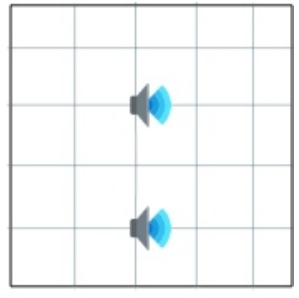
Figure 5. Linear Array.